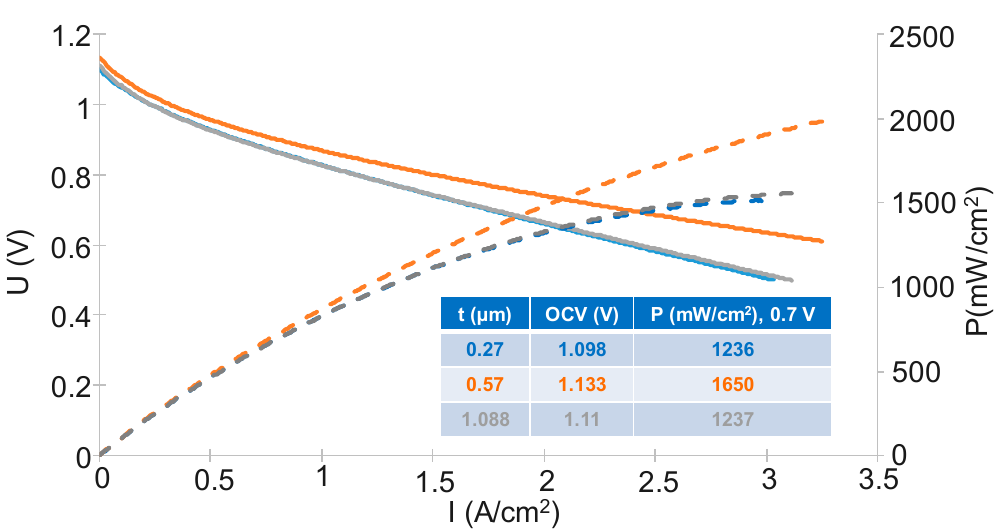
Figure 5. Potential and power versus current of a 2R-Cell™ equipped with a GDC buffer layer deposited via reactive magnetron sputtering under 0.1 Pa and different thickness.